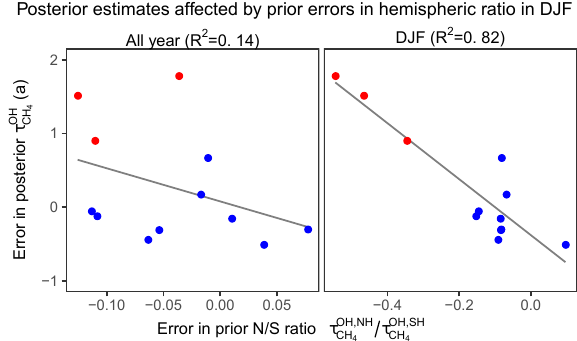
Figure 11. Relationship between errors in posterior estimates of (cid:14) τ OH,SH τ OH ratio for the entire and errors in the prior τ OH , NH CH 4 CH 4 CH 4 year and for boreal winter (December, January, and February). Red dots represent the three cases with large positive errors in posterior estimates of τ OH in Fig. 10 and blue dots represent the other nine CH 4 cases. The plots show that the large errors in posterior estimates of (cid:14) τ OH,SH τ OH are associated with large errors in the prior τ OH , NH CH 4 CH 4 CH 4 = 7 . 5 years. GEOS-Chem v5 is ratio in DJF CH 4 = 8 . 6 years. The CH 4 = 8 . 6 years CH 4